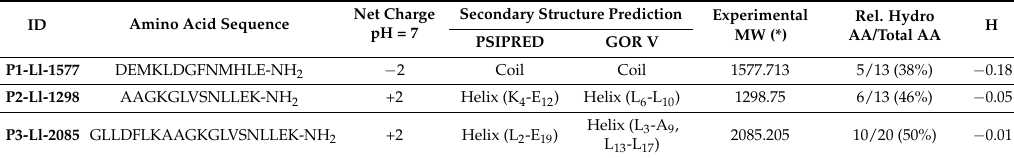
Table 2. Amino acid sequences and properties of the analogs